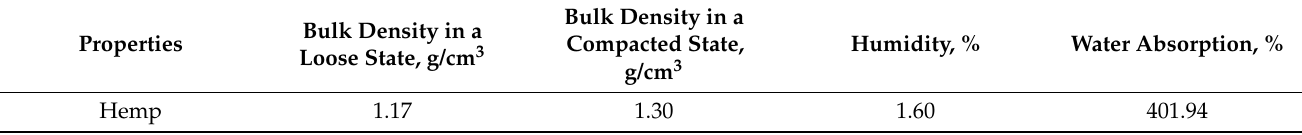
Figure 1. Hemp shives used in the preparation of geopolymer mortar. Table 2. The main properties of the hemp.